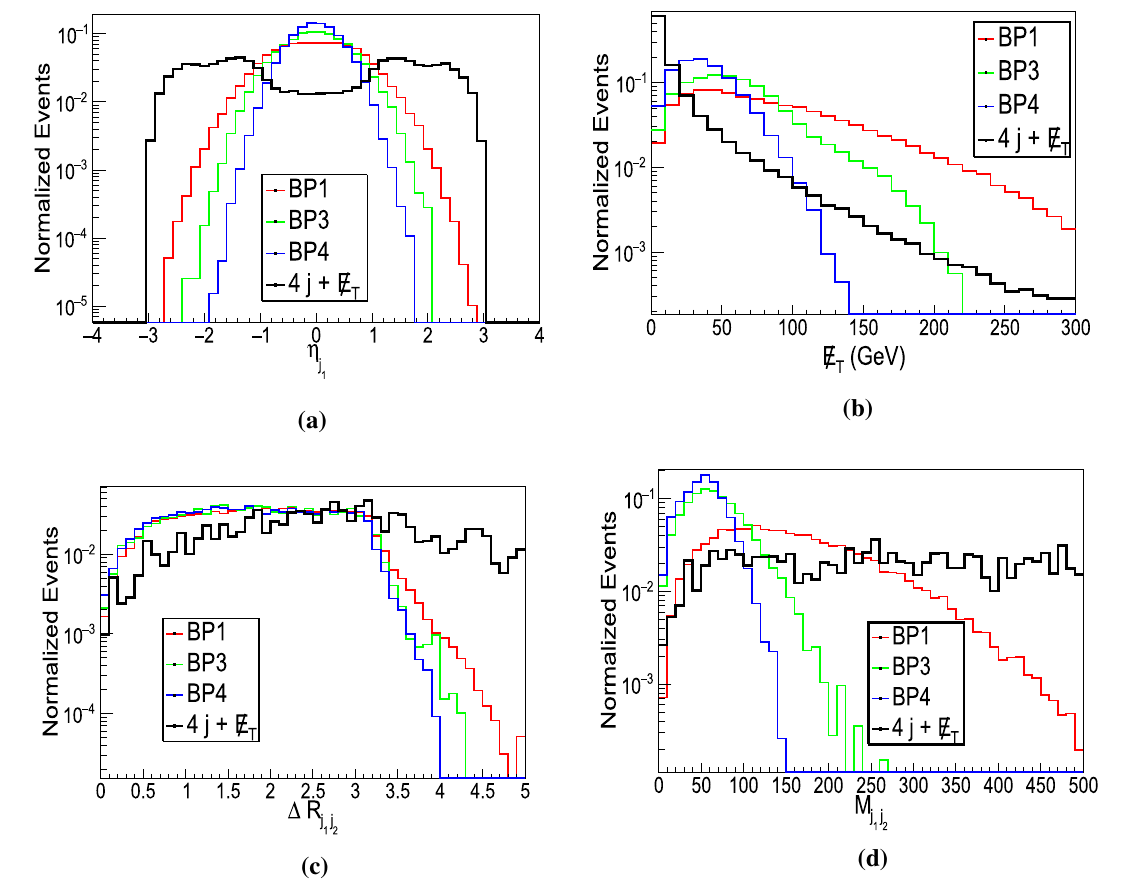
, E / ,(cid:12) R , M + E / T j 1 j 2 j 1 j 2 for 4 j T channel at 1 TeV ILC 1 bracketed term in the D 4 cut denotes the surviving number of events < 150 GeV cut for the background for M j i j k